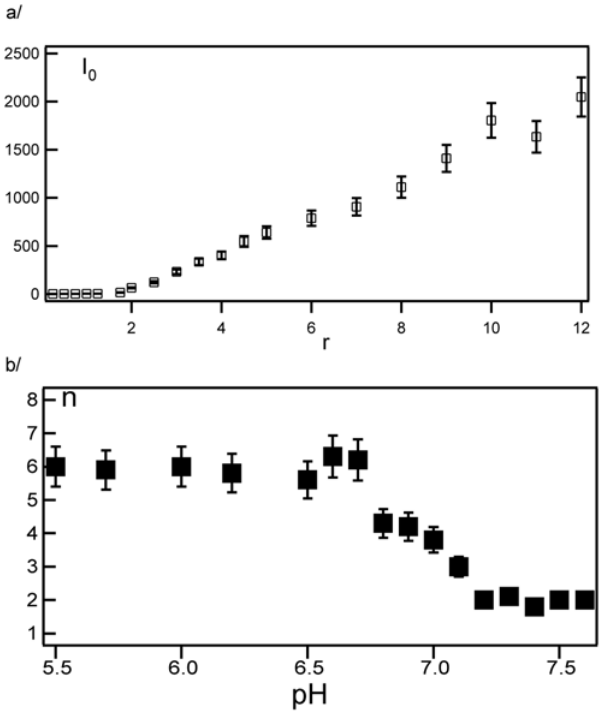
Figure 6. Determination of the stoechiometry of the complex MexA-OprM: Evolution of the intensities of free MexA with the molar ratio r and the evolution of the stoichiometry with pH. (a) Variation of the intensity I 0 associated to free FITC-labeled MexA proteins as a function of molar ratio r . In this experiment, d W =200 A˚ and pH=7.5. This variation provides the stoichiometry number equal to n MexA /n OprM =2. (b) Variation of the stoichiometry number with pH.